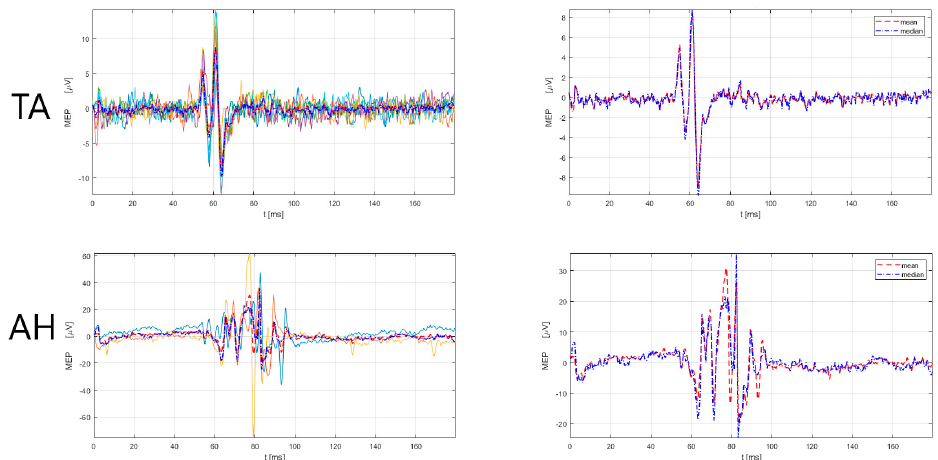
Figure 3. MEP responses for lower extremity (TA, AH) muscles, right side for No3 subject. Left: superimposed responses, Right: mean and median responses. TA = tibialis anterior, AH = abductor hallucis. Legend: the red dashed line denotes the mean response of all MEPs, and the blue dash-dotted line represents the median response of all MEPs. MEP latency and amplitude estimation was performed by a custom-made Matlab script (R2021a) using an automatic algorithm, developed by Šoda et al. (2020) [68].